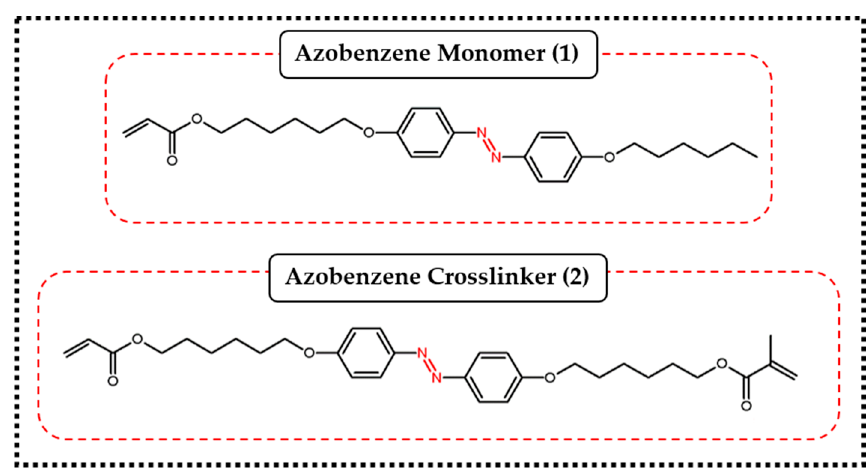
Figure 4. Chemical structures of azobenzene chromophores (monomer and cross-linker) used to prepare liquid-crystalline gels (LCGs) by Ikeda et al. [51].